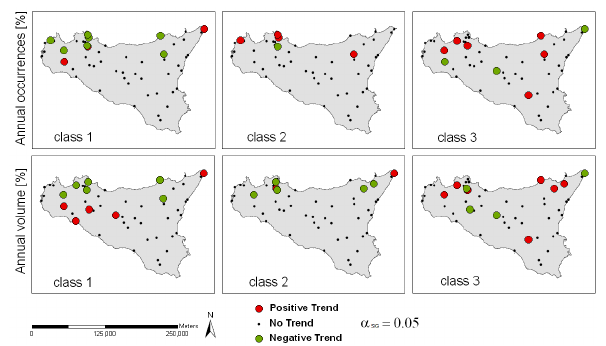
Figure 6. Daily rainfall analysis: results from single rain-gauge station for the two considered stochastic variables (contribution to annual occurrences and rainfall contribution to the total annual volume from each class) and classification B . Here only the presence, either positive (red circles) or negative (green circles), and the absence of trend (black points) are depicted.